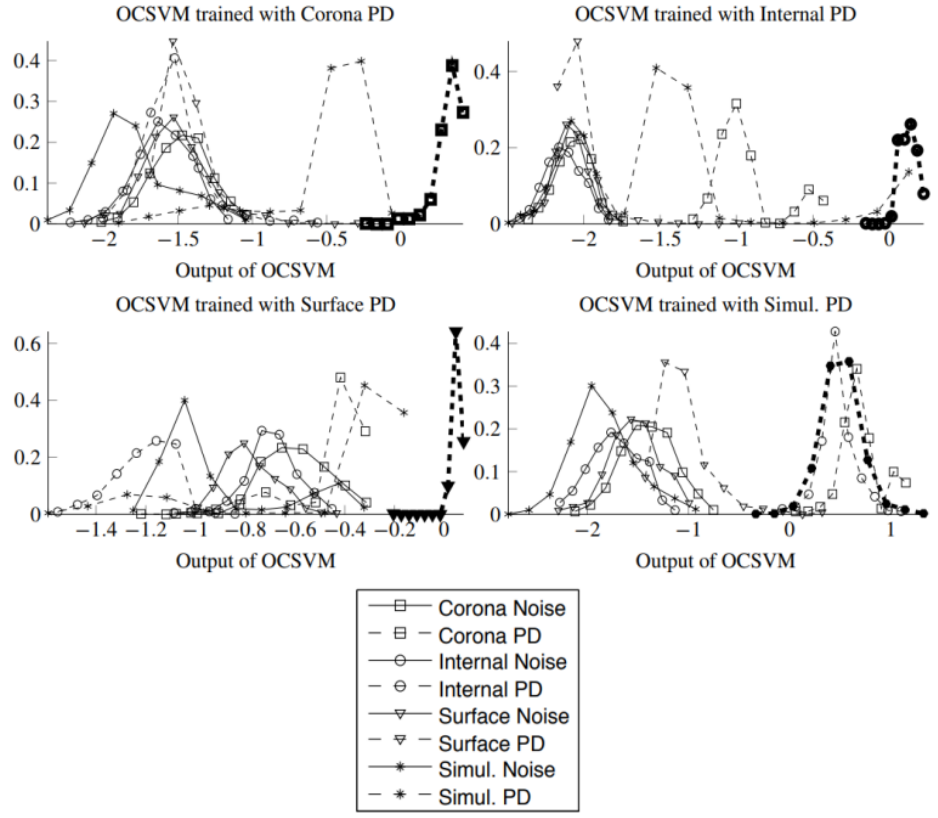
Figure 7. Normalized histograms of the output of the OCSVM trained with PD examples when the test signals are either background noise (solid lines) or PD (dashed lines) from the different experiments. The histogram corresponding to the class of the training set is plotted with double line width. Table 4. Agreement (percentage of times in which both classifications coincide) between the OCSVM and a binary SVM trained with data collected in the scenario corresponding to the test set. In order to align the classifications of both methods, we compute as one agreement when either both OCSVM and SVM classify the same test pulse as noise or when the SVM classifies it as PD and the OCSVM as not-noise. Any other situation counts as a disagreement. The top number in each cell indicates the agreement when the bias term of the OCSVM (cid:2025) is the output of the optimization of (2) subject to (3) and (4). The bottom number is the agreement when (cid:2025) is further refined using an extra training set of noise recorded from the same scenario of the test data but not included in the test set. The test data includes pulses of noise and PD.